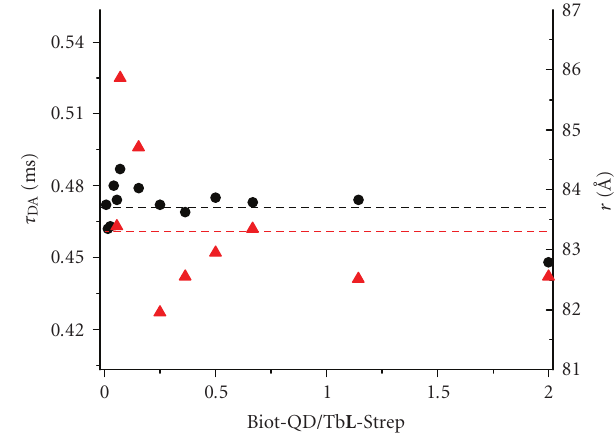
Figure 4: Luminescence decay times of Tb and QDs ( τ DA ) due to QD FRET sensitization by Tb and donor-acceptor distances ( r ) cal- culated from luminescence decay curves of channel A (black dots) and channel B (red triangles), respectively. The dashed lines repre- sent mean values of τ DA and r